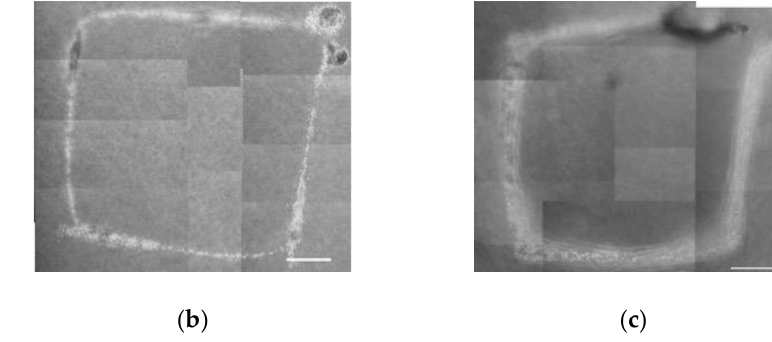
Figure 8. Phase-contrast images of square pattern of PC-12 cells injected in atelocollagen sol or gel at ( a ) 25 °C, ( b ) 30 °C, and ( c ) 35 °C. Scale bar = 1 mm.